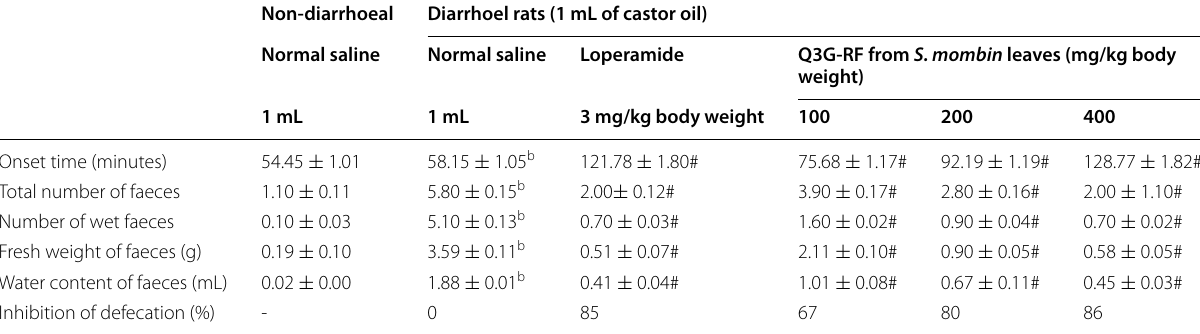
Values are mean of 6 replicates SEM, significant differences from the sham control group are indicated by b and from negative control by #, p < ±